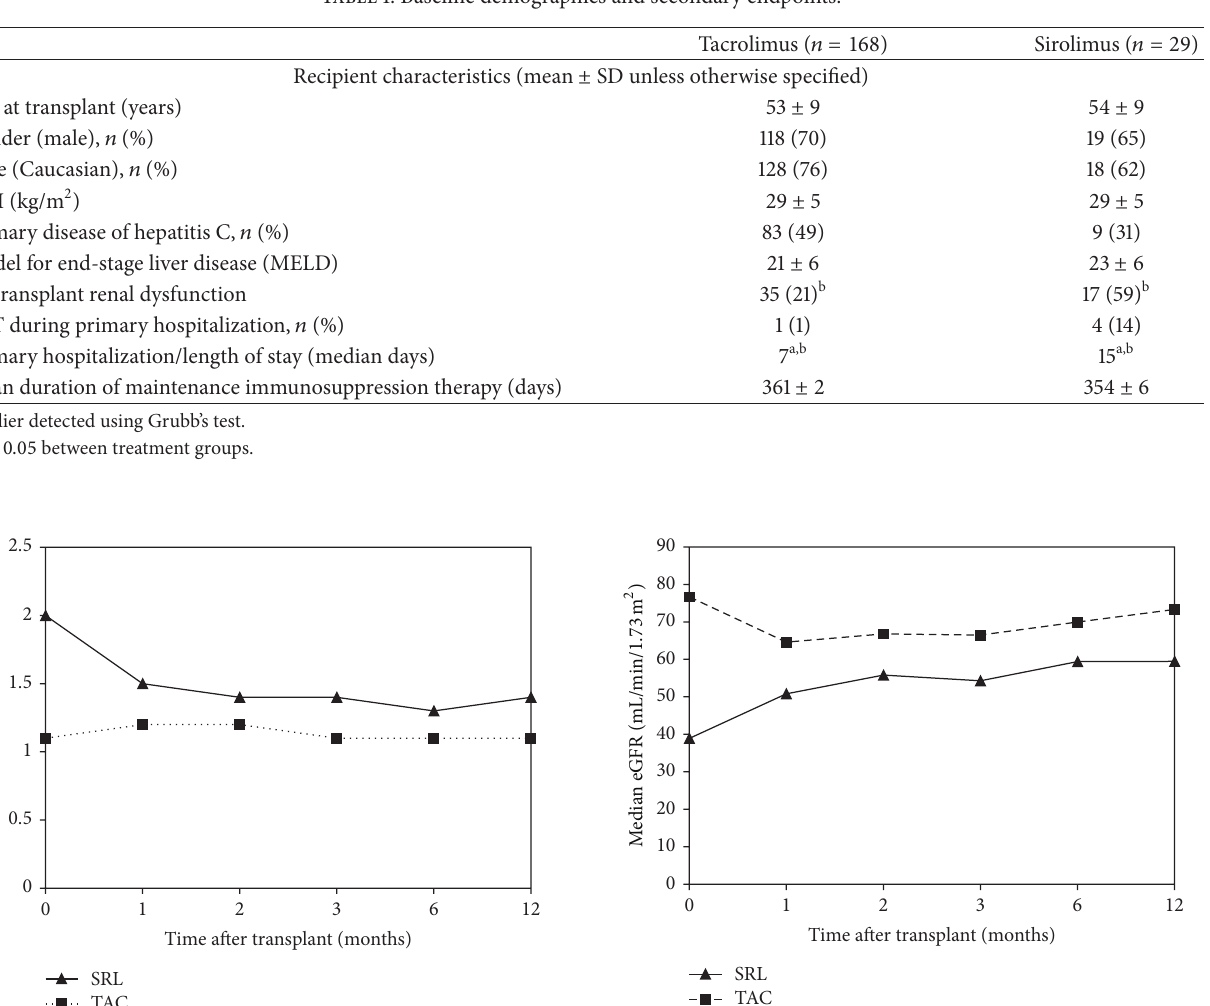
Table 1: Baseline demographics and secondary endpoints.